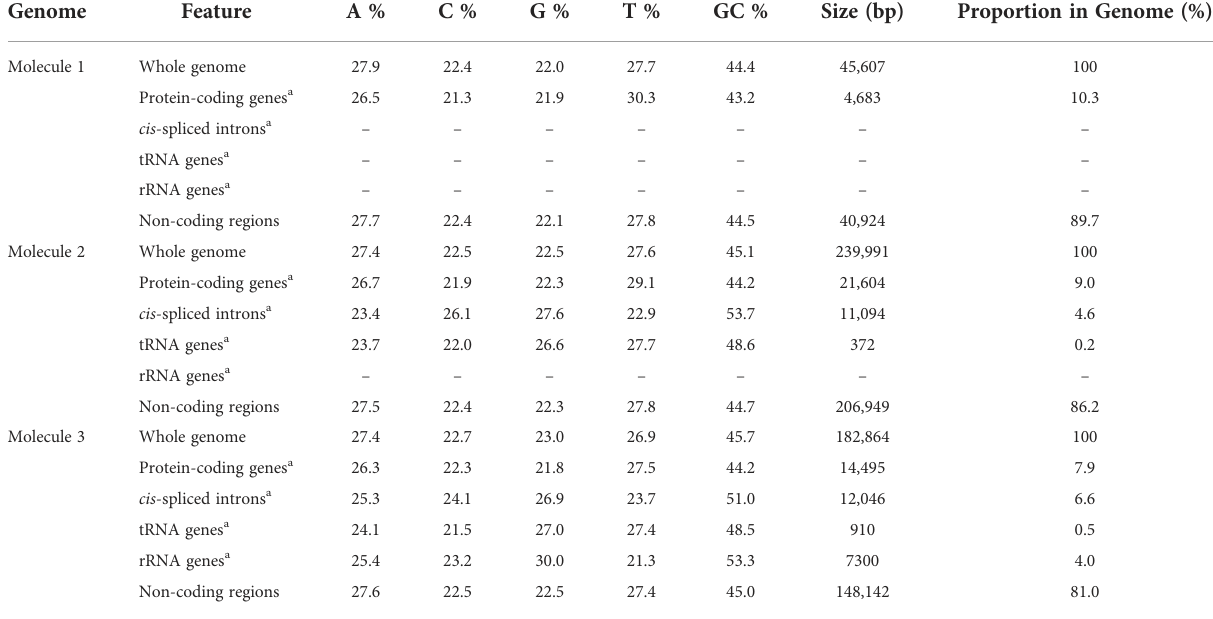
TABLE 1 Genomic features of the H. citrina mitogenome.